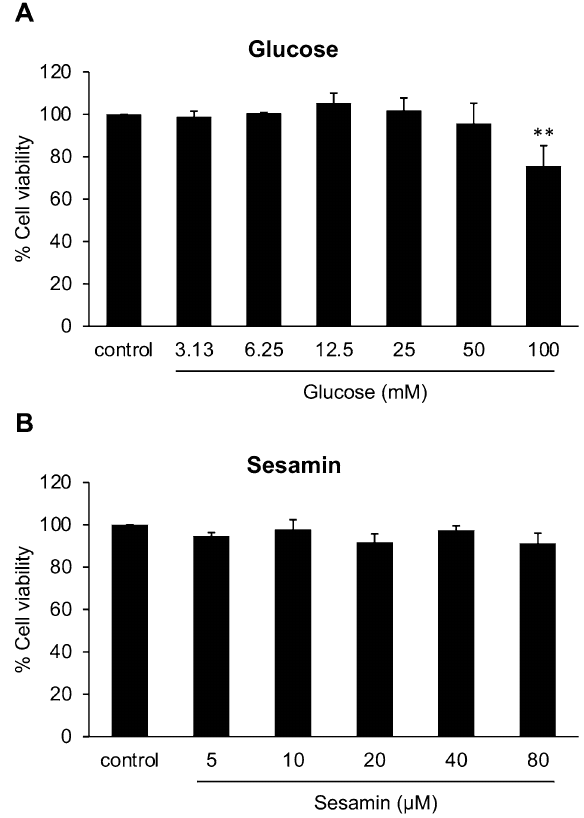
Figure 1. Effects of ( A ) glucose and ( B ) sesamin (Se) on BV2 cell viability. Cells were incubated with diverse doses of glucose (0–100 mM) or sesamin (0–80 μM) for 48 h. The BV2 cell viability was detected by MTT assay. The results are showed as the mean ± SEM from three independent experiments. ** P < 0.05 versus the control